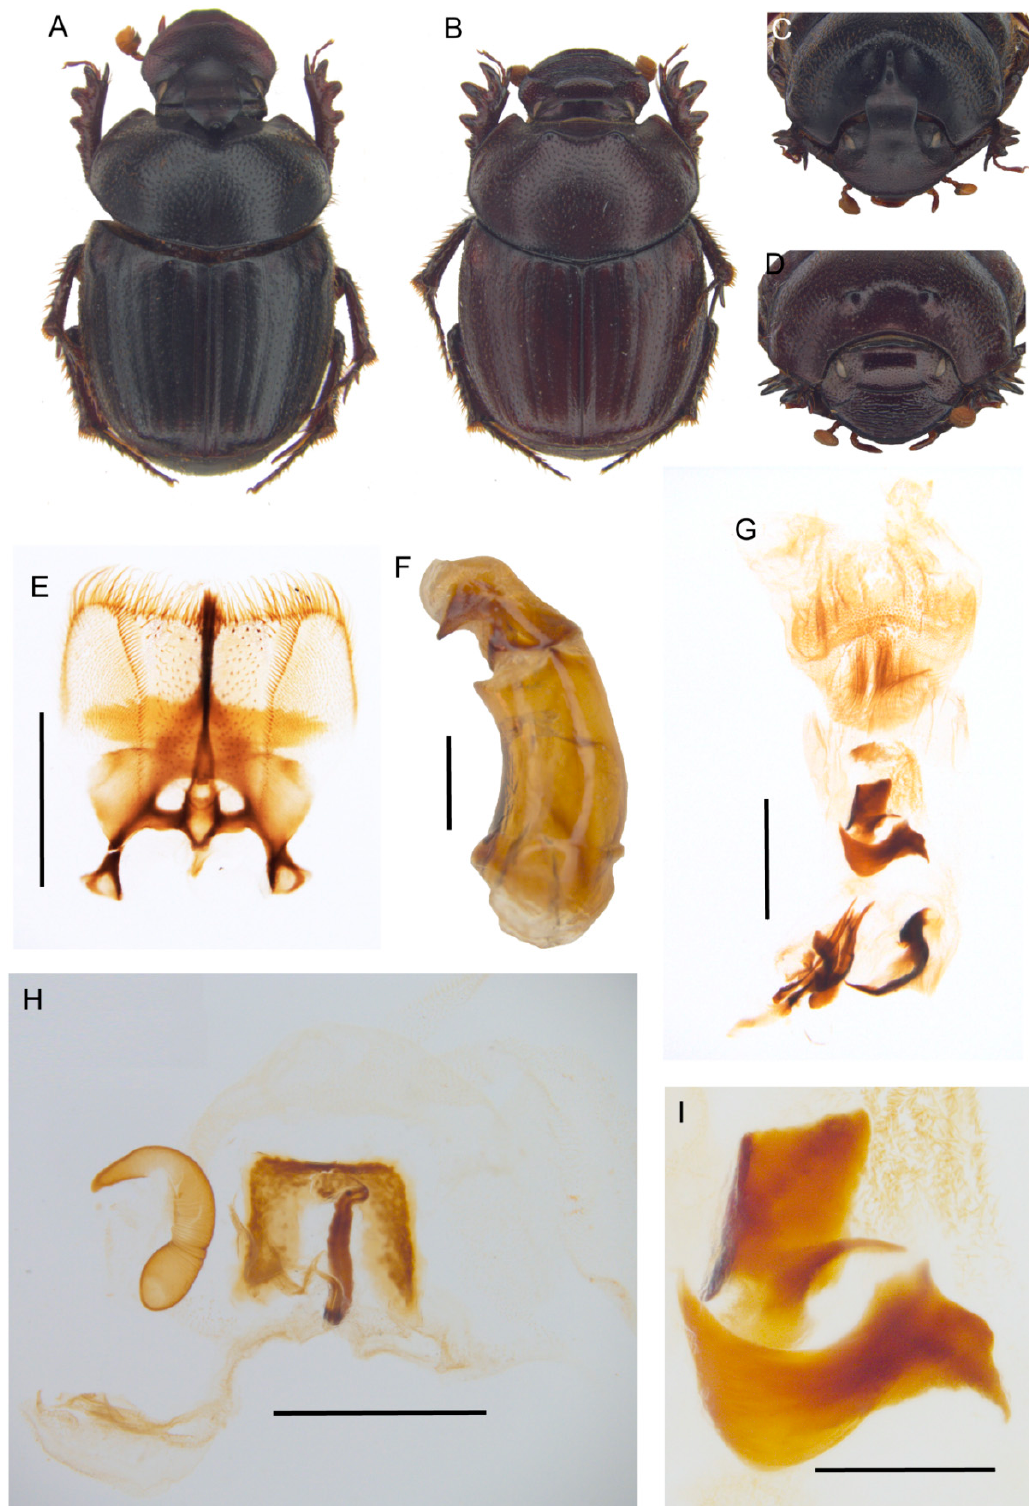
Figure 8. Features of Tiaronthophagus angolensis n.sp . (A) : Male facies (above). (B) : Female facies (above). (C) : Male facies (frontal view). (D) : Female facies (frontal view). (E) : Epipharynx, scalebar = 0.5 mm. (F) : Male genitalia, phallobase and parameres, scalebar = 0.5 mm. (G) : Male genitalia, endophallus, scalebar = 0.5 mm. (H) : Female genitalia, vagina and receptaculum seminis, scalebar = 0.5 mm. (I) : male genitalia, lamella copulatrix, scalebar = 0.2 mm.